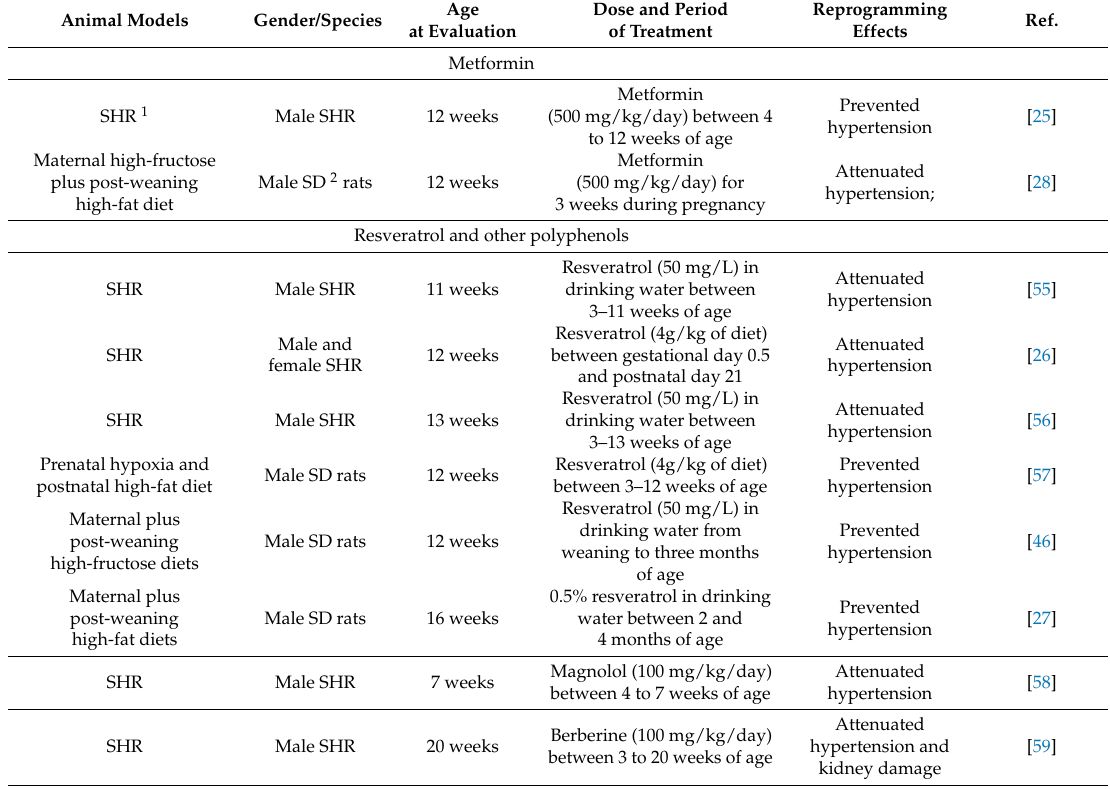
Table 1. Reprogramming strategy targeted on AMPK signaling in animal models of programmed hypertension and kidney